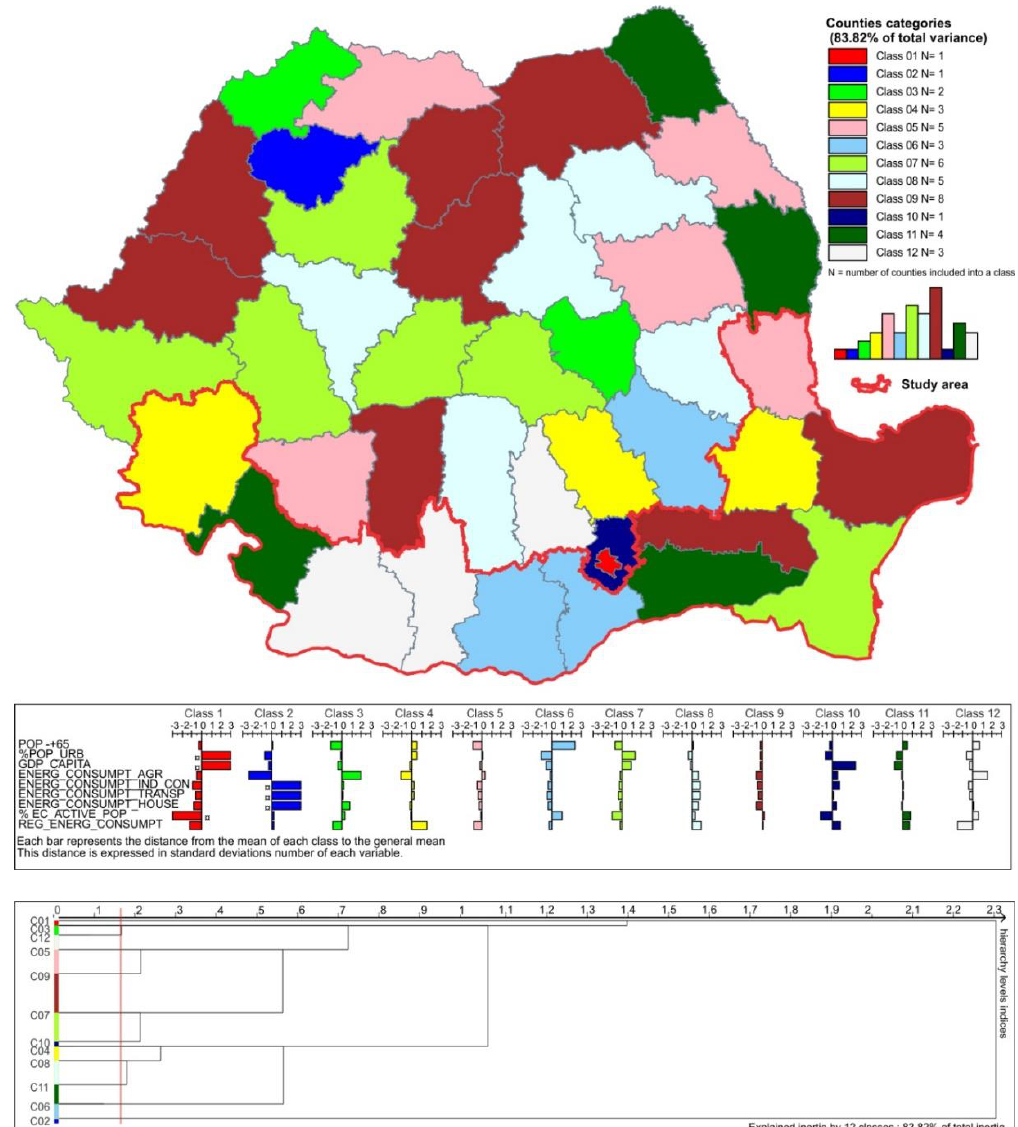
Figure 5. Spatial distribution of the demographic and economic indicators in 2010 (Source: TEMPO Online, National Institute of Statistics), (made with Philcarto, http://philcarto.free.fr).